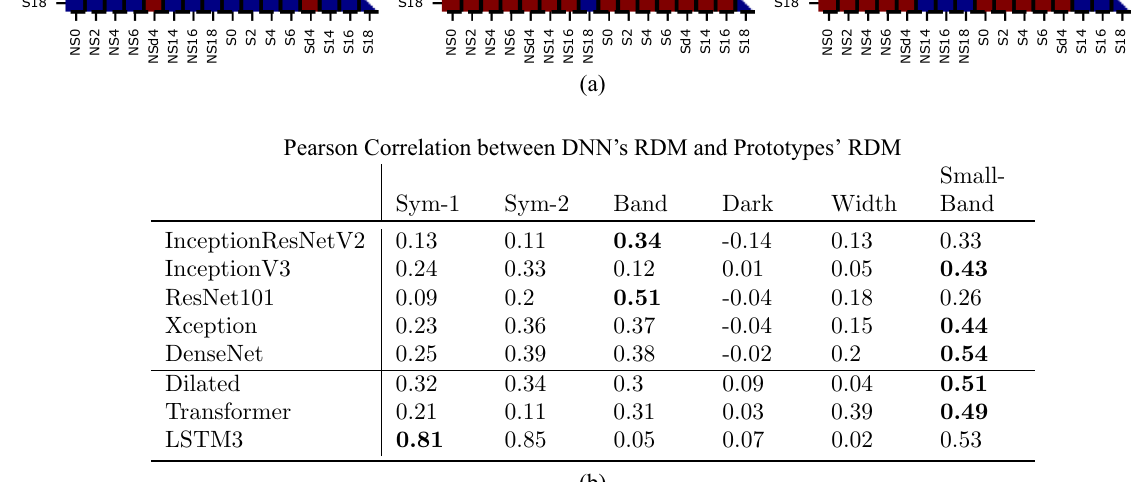
Figure 5. Results of representational similarity analysis (RSA). ( a ) Hypothetical patterns showing how the RDMs would look like from perfect classifiers of different features (symmetry, presence of a band, brightness level, or band width). The white area in Symmetry-2 is not included in any correlation calculations. ( b ) Pearson Correlation Coefficients between the RDM of each model (displayed in Supplemental Fig. 1) and the RDM of each